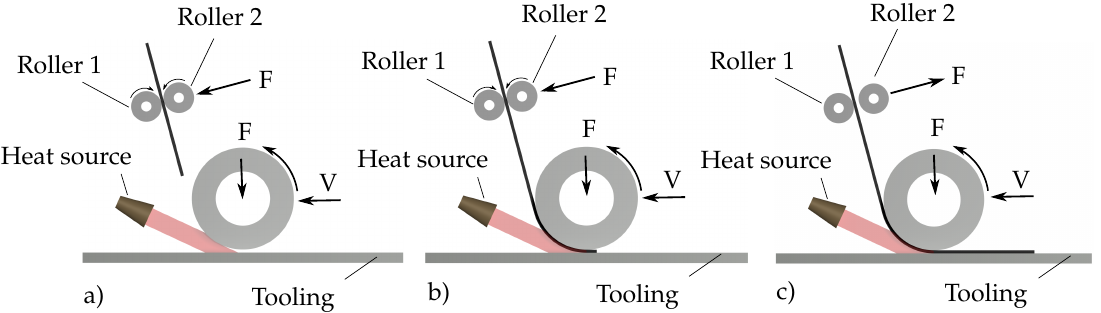
Figure 4. Functional principle Active and Passive Feeding System in